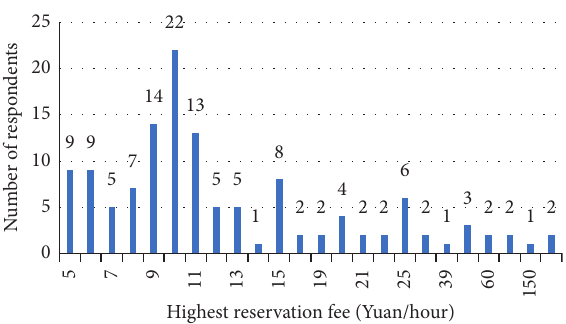
Figure 7: Acceptable highest reservation fee.